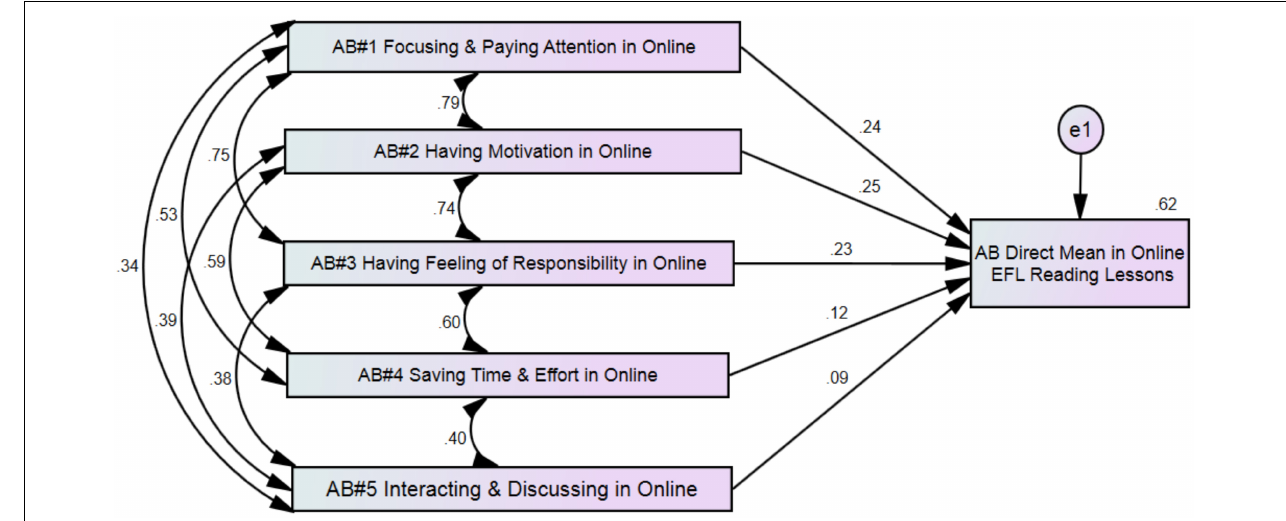
FIGURE 3 | Attitude toward behavior (AB) diagram for the OLL group.